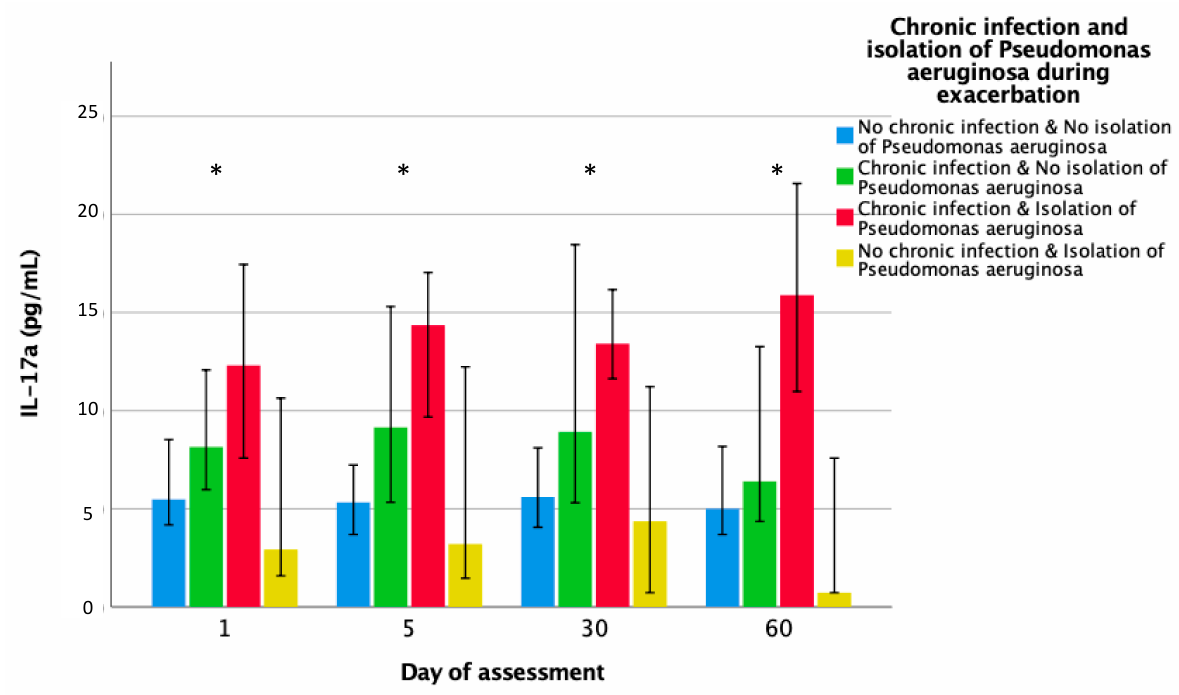
Figure 3. Systemic IL-17a levels by microorganisms isolated at exacerbation. Systemic levels of IL-17a are shown according by chronic PA infection and microorganisms isolated at exacerbation (PA vs. non-PA). * p < 0.05 for ANOVA test. No chronic infection and no isolation of Pseudomonas aeruginosa , N = 81 (blue); Chronic infection and no isolation of Pseudomonas aeruginosa , N = 40, (green); Chronic infection and isolation of Pseudomonas aeruginosa , N = 32 (red); No chronic infection and isolation of Pseudomonas aeruginosa , N = 12 (yellow). Bars represent the median and error bars represent 95% Confidence Intervals. Abbreviations: IL, Interleukin; PA, Pseudomonas aeruginosa .